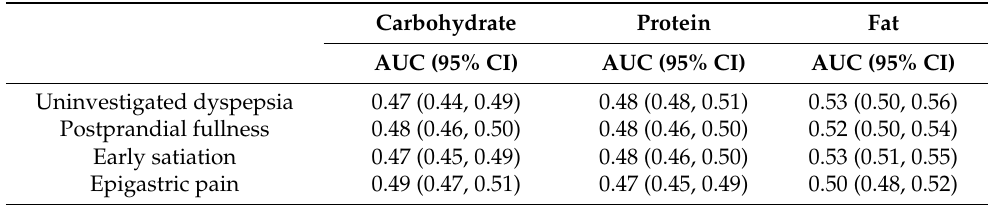
Table 5. Area under receiver operating characteristic curve for uninvestigated dyspepsia and its symptoms by individual